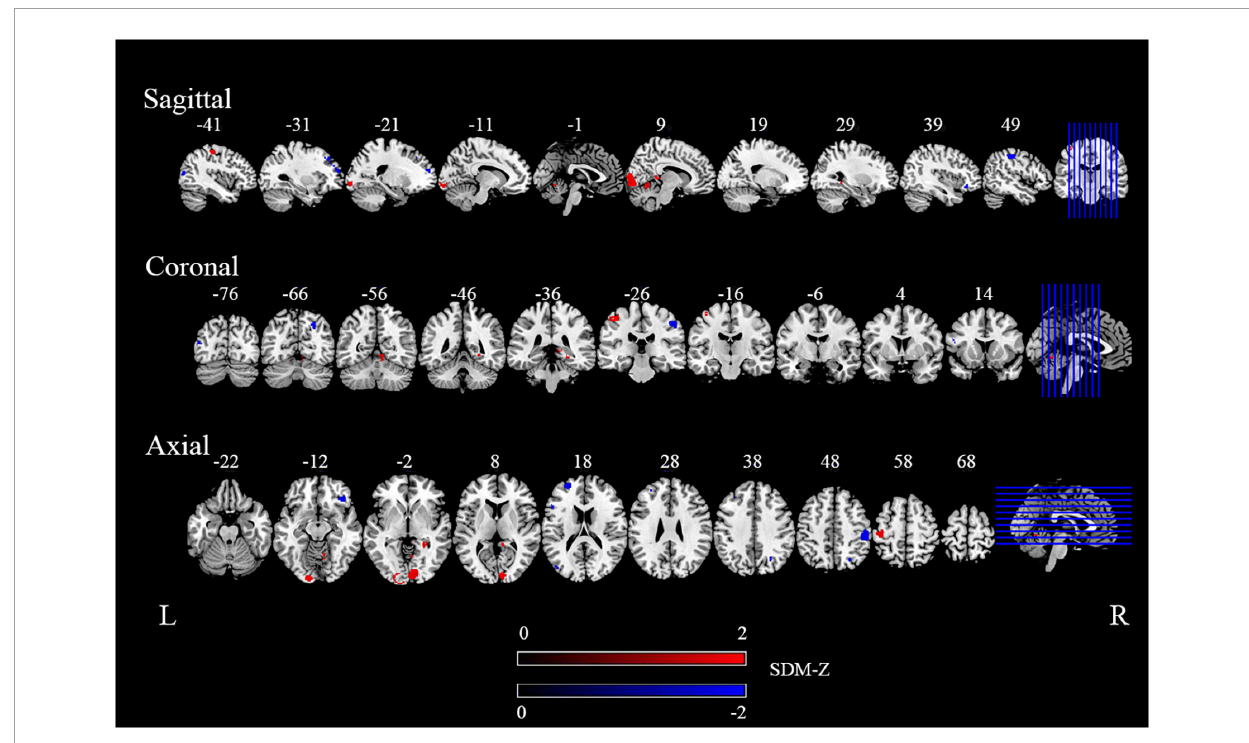
FIGURE2 The areas of increased (red) and decreased (blue) functional connectivity (FC) in the main meta-analysis. “R” and “L” denote the right and left sides of the brain, respectively. The color bar indicates the maximum and minimum seed-based d mapping (SDM)-Z value.